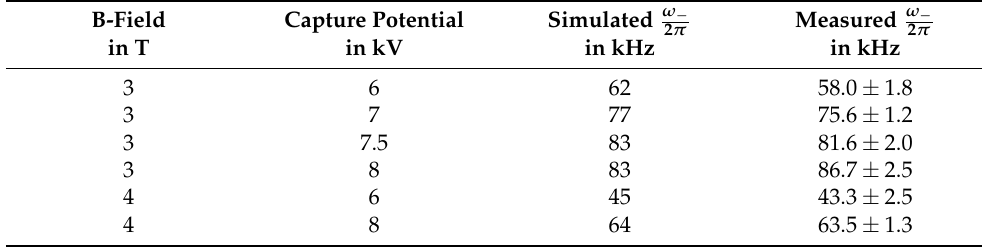
Figure 3. Ion signal plotted over the storage time. The subplot in the top right corner shows the result of a fast Fourier transform of the ion signal. Table 1. Measured and simulated magnetron frequencies ω − for various trap